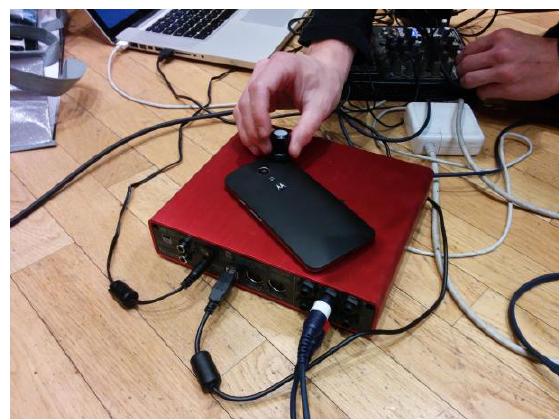
Figure 5. Using a pick-up coil to amplify the audio output of a smartphone